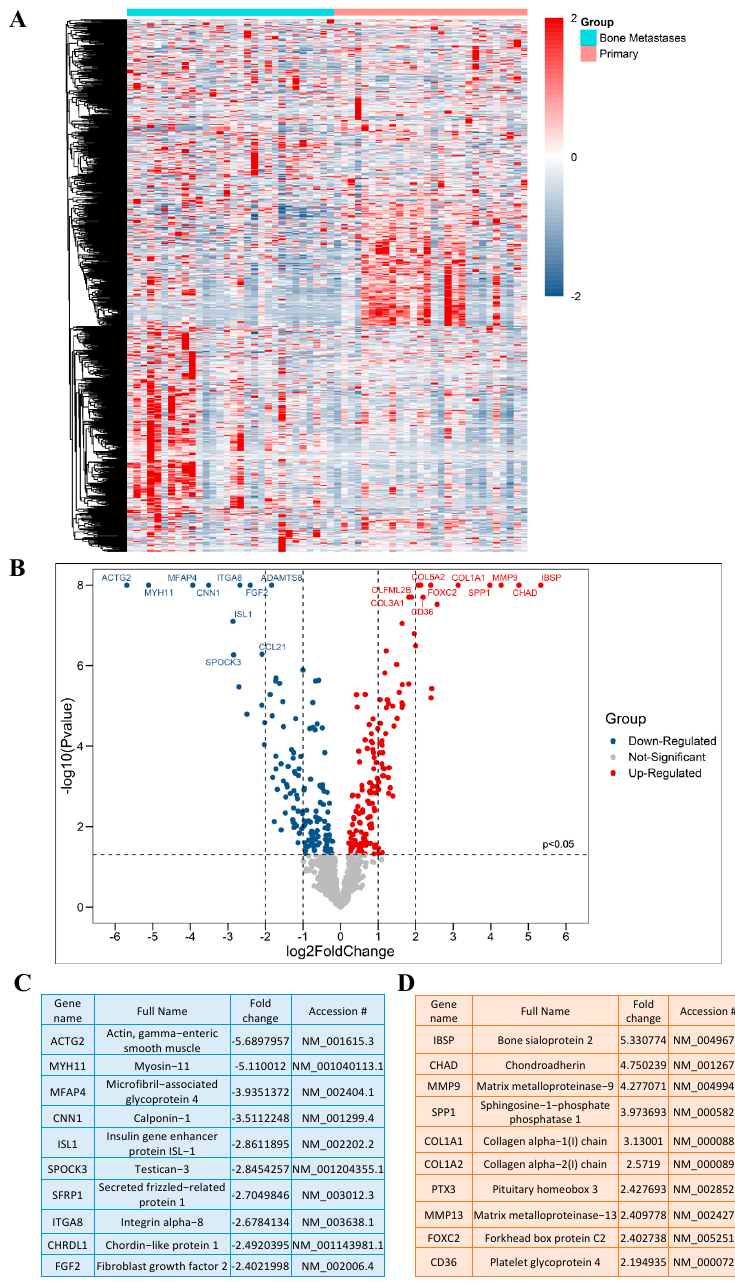
Figure 2. DEGs in PCa BM. ( A ) Heat map representing DEGs, produced by “Morpheus”. ( B ) Volcano plot of significant DEGs based on the p -value and fold change; Up indicates upregulated and Down indicates downregulated genes. ( C ) Top 10 significantly downregulated DEGs based on the fold change. ( D ) Top 10 significantly upregulated DEGs based on the fold change.